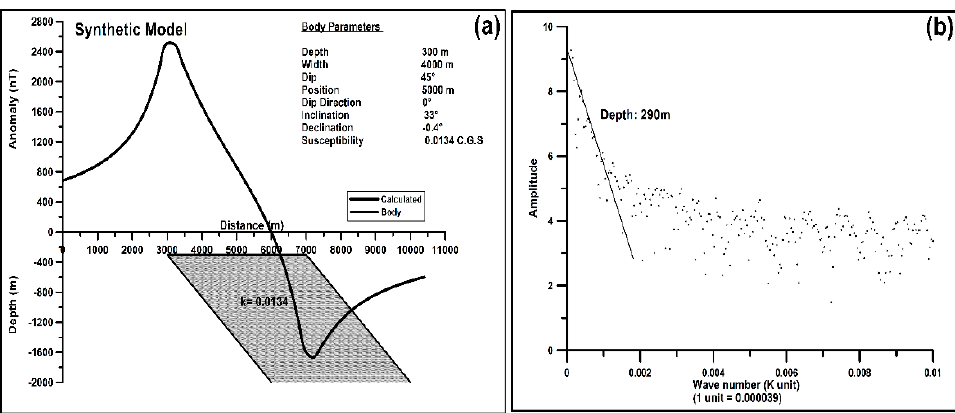
Figure 7. ( a ) synthetic magnetic anomaly at geomagnetic latitude and ( b ) power spectrum map showing the depth.